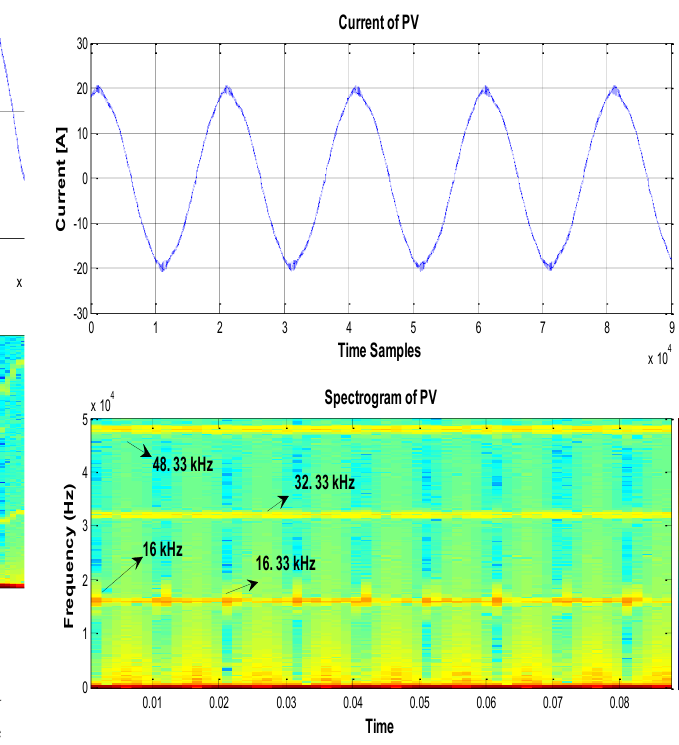
Fig 7. Spectrogram of the current power line with PV (Sampling Frequency: 1 MHz) In figure 7 is illustrated Continuous and fluctuant frequency emissions at 16 kHz output PLC frequency and Daylight emission at 32 kHz PV inverter signature